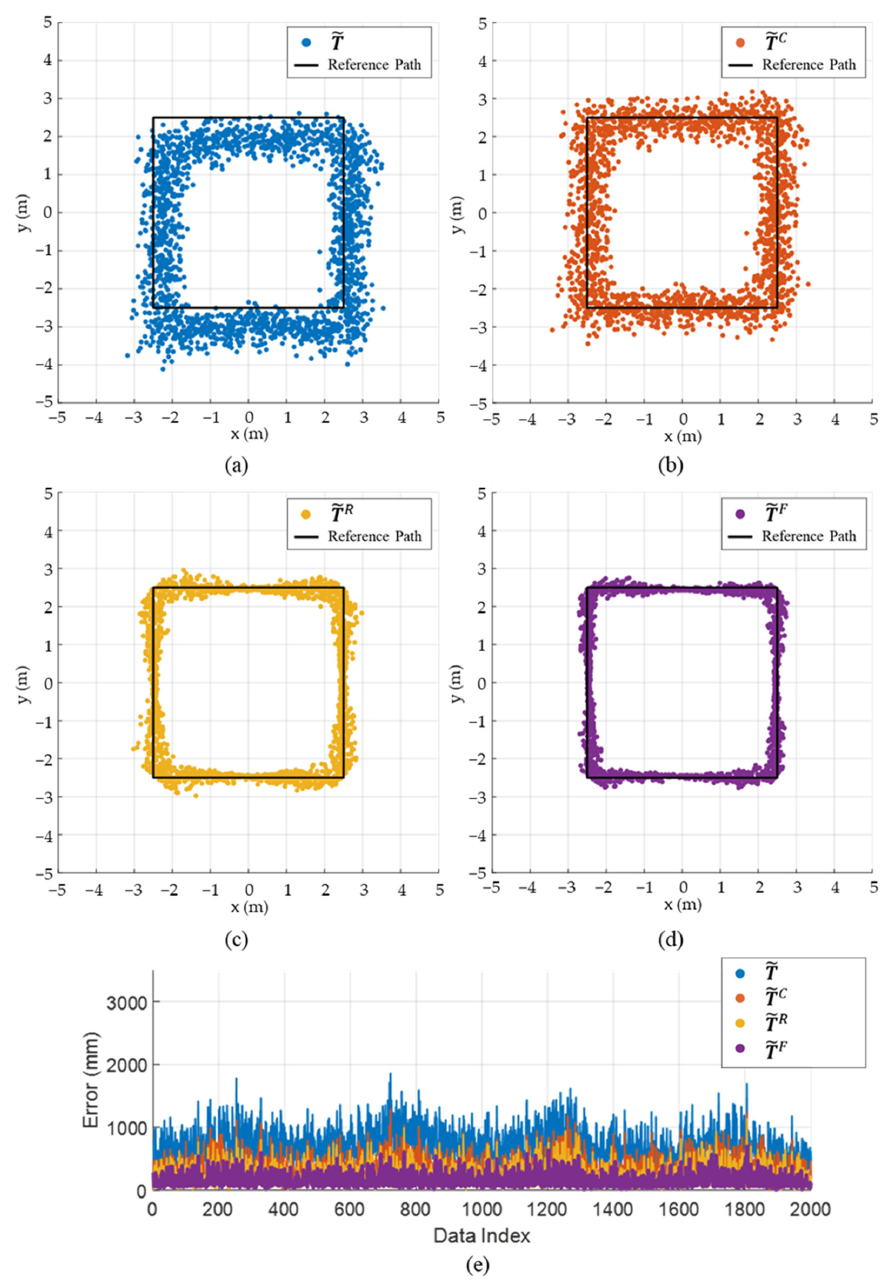
Figure 8. Simulation results demonstrating the estimation accuracy of the proposed method for the square path: ( a ) estimation results of 𝑻(cid:3561) , ( b ) estimation results of 𝑻(cid:3561) (cid:3004) , ( c ) estimation results of 𝑻(cid:3561) (cid:3019) , ( d ) estimation results of 𝑻(cid:3561) (cid:3007) , ( e ) comparison of estimation error for 𝑻(cid:3561),𝑻(cid:3561) (cid:3004) ,𝑻(cid:3561) (cid:3019) ,𝑎𝑛𝑑 𝑻(cid:3561) (cid:3007) .